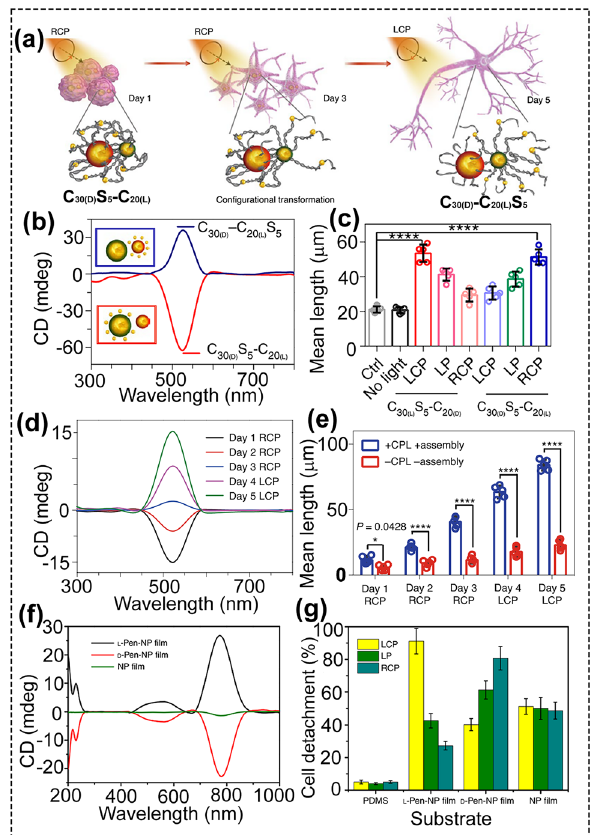
Fig. 8 a Schematic of differentiation of NSCs with CPL after daily incubation with C30(D)S5-C20(L) for five days. b CD spectra of C30(D)S5-C20(L) and C30(D)-C20(L)S5 in phosphate buffered saline. c Neurite mean length of differentiated NSCs incubated